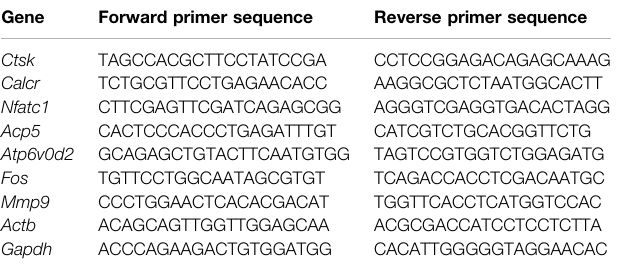
TABLE 1 | Osteoclastogenesis-related gene primer sequences.